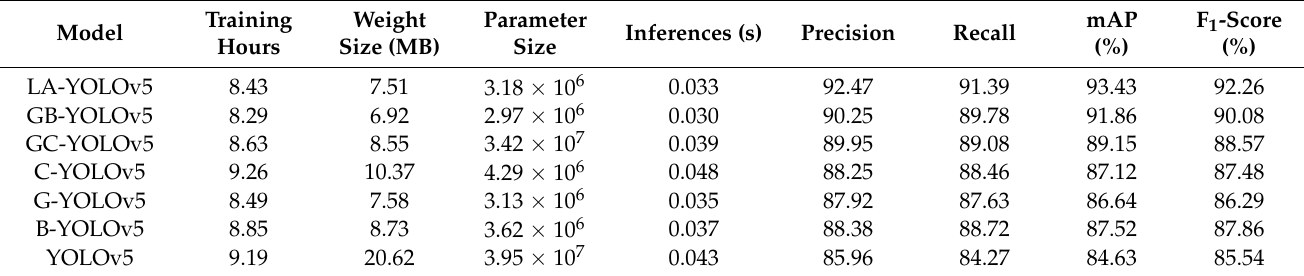
Table 3. Comparison of building damage detection in ablation experiments. Model